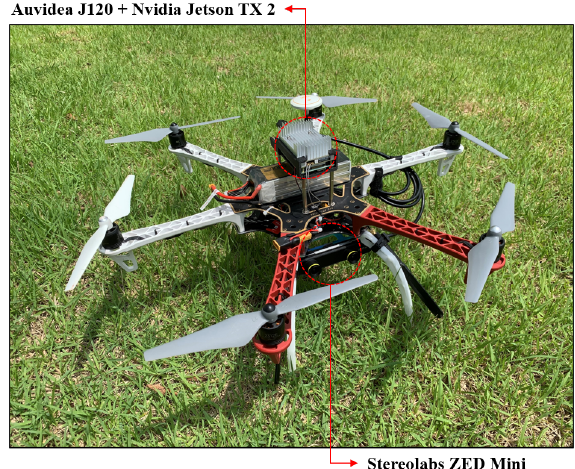
Figure 5. Customized DJI F550 hexacopter.